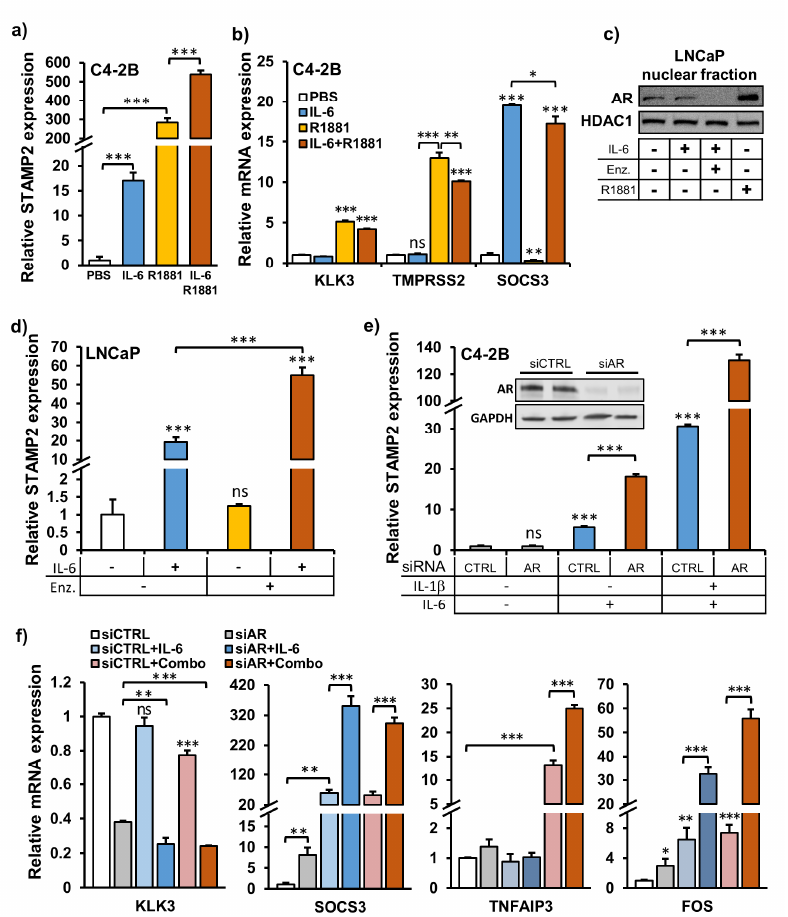
Figure 3. Cytokine-induced STAMP2 expression in PCa cells is independent of AR. ( a , b ) C4-2B cells were androgen- starved for 24 h followed by treatment with 20 ng/mL IL-6, 1 nM R1881, or their combination for 24 h. Total RNA was harvested and subjected to qRT-PCR analysis. Statistics shown by asterisks above the columns are relative to respective PBS treatments. ( c , d ) LNCaP cells were pretreated with or without 2 µM enzalutamide (Enz.) for 2 h and then treated with 30 ng/mL IL-6 for 2 h. As a control for AR induction, 5 nM R1881 treatment was applied overnight. The cells were harvested for Western blot analysis of the nuclear AR protein level ( c ) and qRT-PCR analysis of STAMP2 expression ( d ). ( e , f ) C4-2B cells were cultured and transfected with AR siRNA or control siRNA for 48 h. The cells were then harvested followed by Western blotting for detection of AR protein levels and qRT-PCR for detection of indicated genes expression. Combo stands for combinatorial treatment with IL-6 and IL-1 β . Statistics shown by asterisks above the columns are relative to non-induced siCTRL treatment. * p < 0.05, ** p < 0.01, *** p < 0.001.